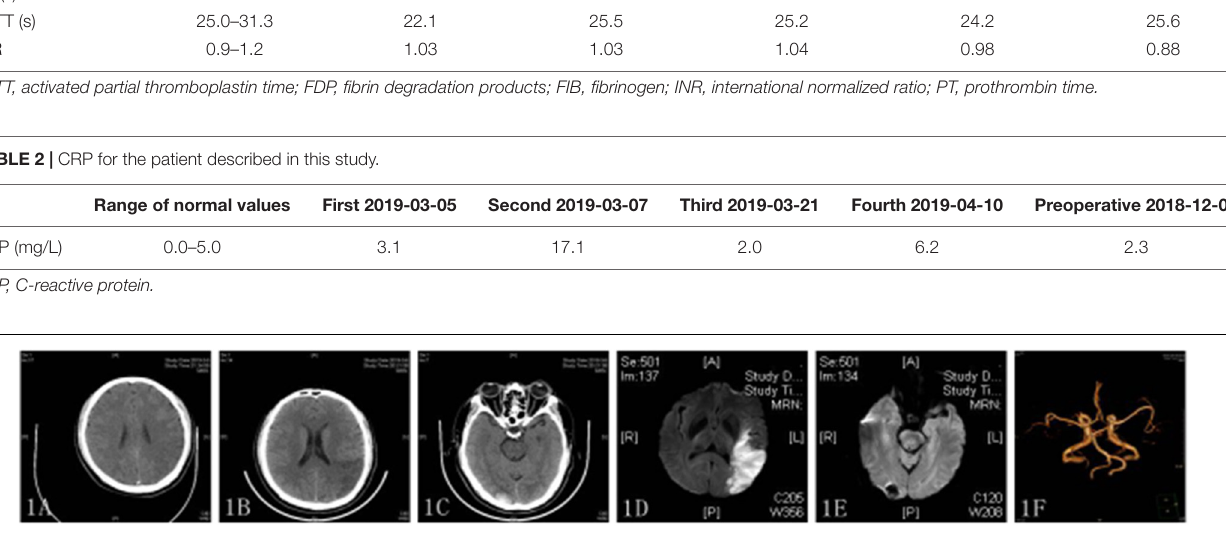
FIGURE 1 | (A–C) CT image showing an indistinct gray matter boundary of the left frontal gyrus (A) ; a large, low-density shadow in the left parietal occipital lobe (B) ; and multiple high-density shadows on both sides of the occipital lobe (C) . (D,E) Diffusion-weighted imaging (DWI) showing a high-intensity signal in the left frontoparietal–temporal–occipital artery island (D) and low-intensity signal in the left cerebellar hemisphere (E) . (F) CT angiography showed no stenosis or occlusion.